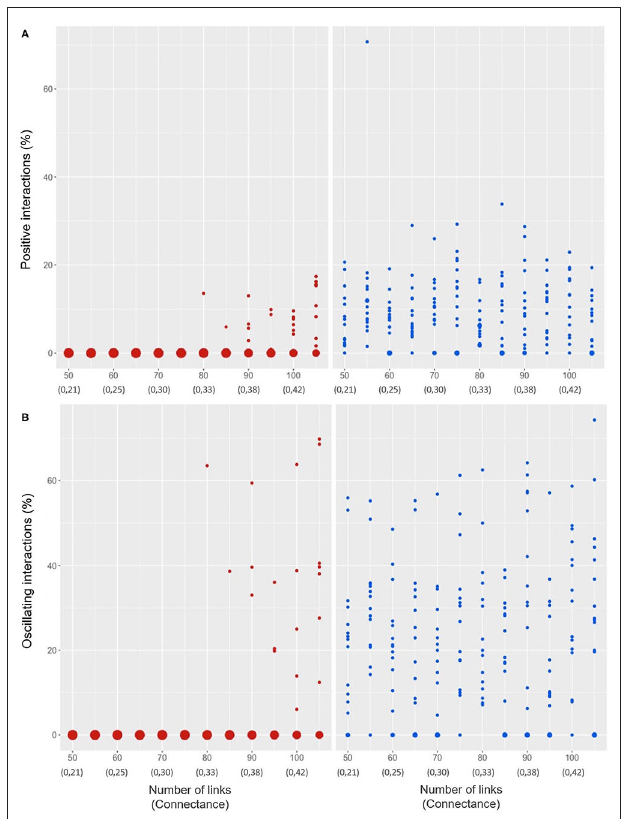
FIGURE 7 | Positive (unilateral) interactions (A) and interactions with oscillating values (B) after experiments as a function of the number of links of the initial networks (corresponding connectance value below). Left column: link up path (red dots); right column: link down path (blue dots). The size of the dots represent the proportion of times that a result (of the 40 repetitions) yields a given value.